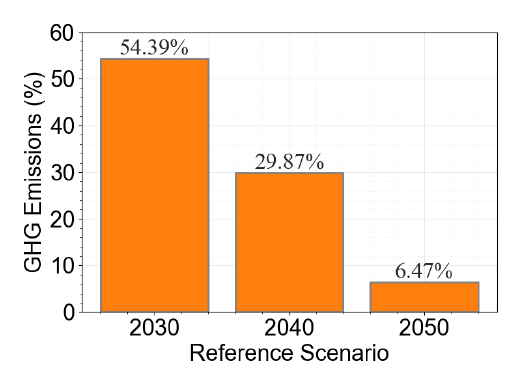
Figure 7. BAU—Evolution of GHG emissions for the service sector